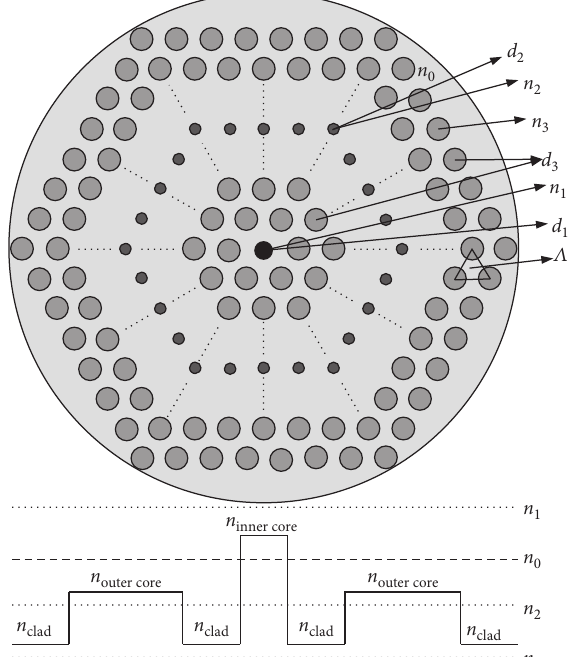
Figure 1: The transverse section and equivalent refractive index distribution for studied all-solid